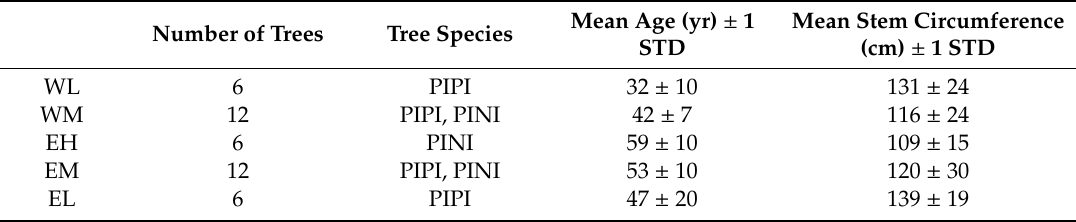
Table 1. Overview of the tree data set. The tree species refers to Pinus pinaster (PIPI) and Pinus nigra (PINI), respectively. Site codes refer to the eastern (E) and western (W) side of Corsica, L, M, and H stand for low-, middle-, and high-elevation sites, respectively. The ages and stem circumferences are expressed as mean values ± 1 standard deviation (STD). Number of